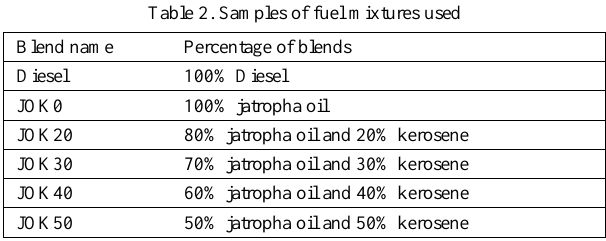
Table 2. Samples of fuel mixtures used